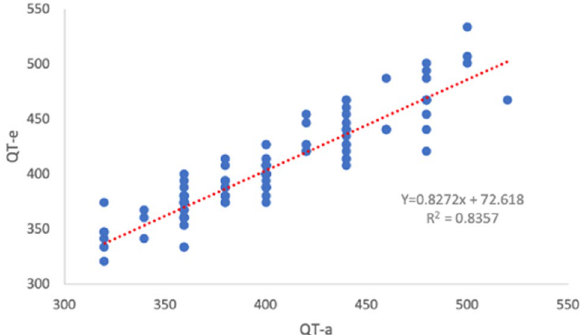
Figure 2. Regression analysis: correlation of mean QT-a (ms) and mean QT-e (ms). Scatterplot and fitted line showing the linear association between the QT mean interval (measured as an average of lead I, lead II, the V2